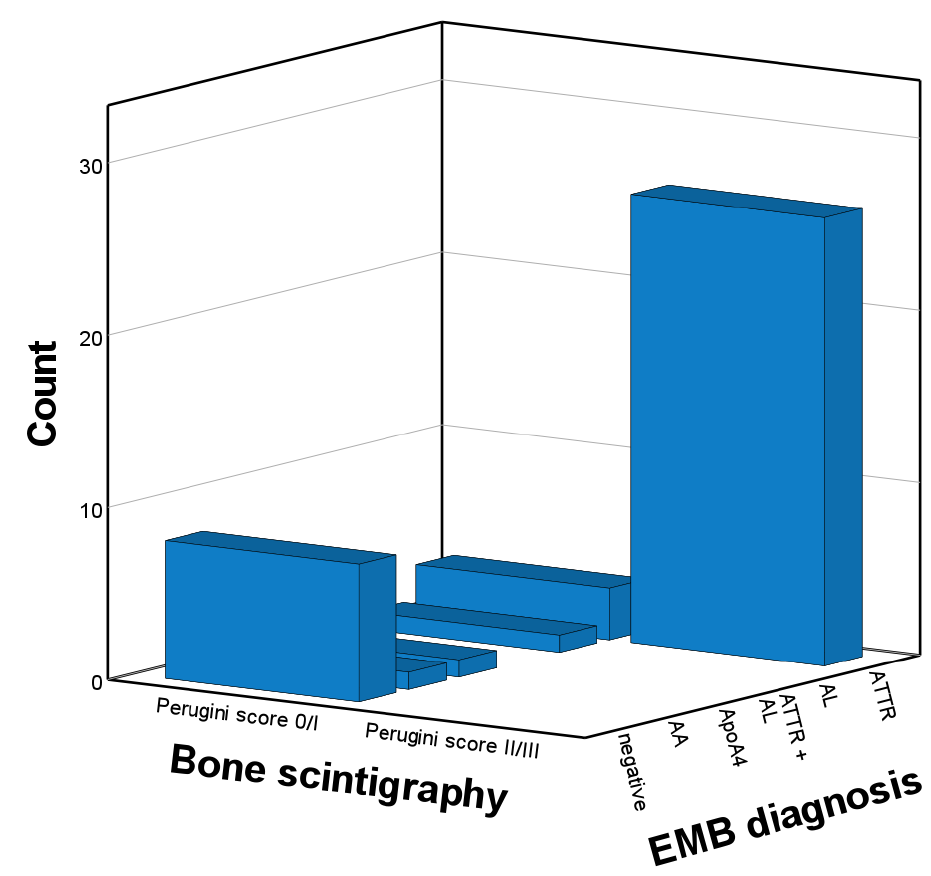
Figure 2. Endomyocardial-biopsy-derived diagnoses stratified by Perugini score of 0/1 vs. 2/3 in patients without monoclonal protein (n = 40). AA, amyloid A; AL, light chain amyloidosis; ApoA4, apolipoprotein A4; ATTR, transthyretin amyloidosis; EMB, endomyocardial biopsy. Table 3. Diagnostic accuracy of bone scintigraphy with a Perugini score ≥ 2 for the histopathological diagnosis of cardiac ATTR in patients with FLC assessment results that were not indicative of monoclonal protein (n = 40).